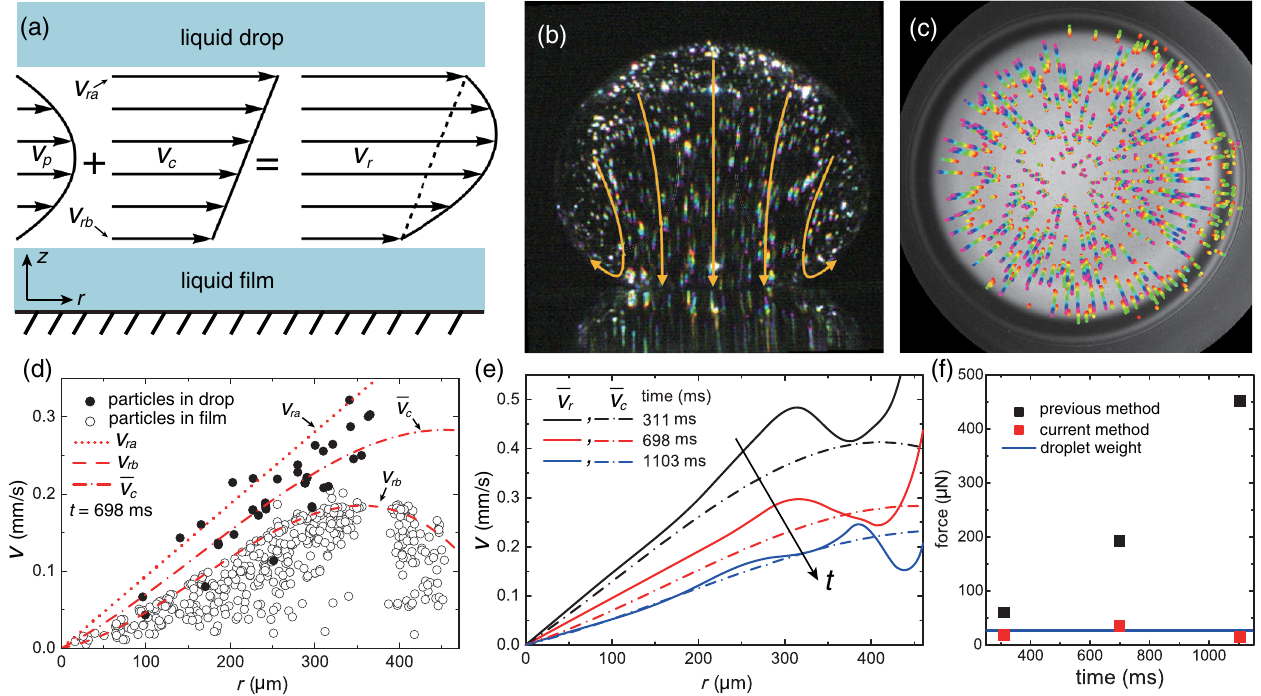
FIG. 3. Boundary velocities significantly influence air leakage. (a) Velocity profiles inside air gap. The total velocity v is composed r from pressure gradient plus a linear profile v caused by boundary velocity. v and v are upper and lower by two parts: a parabola v p c ra rb boundary velocities, respectively. (b) Side view image illustrating the flow inside droplet (also see Movie 4). The bright streaks are tracer particles ’ trajectories moving from the red end to the purple end. This flow provides the outward boundary velocity v from the droplet ra side. (c) Bottom view image illustrating the flow inside liquid film (also see Movie 5). Again, the bright streaks are tracer particles ’ from the liquid film side. trajectories moving from the red end to purple. This flow provides the outward boundary velocity v rb (d) Obtaining v , v , and ¯ v experimentally. At time t ¼ 698 ms, we obtain v and v from tracking particles in droplet (solid ra rb c ra rb symbols) and liquid film (open symbols), respectively. Because particles ’ velocities decrease as their locations are further away from (dotted line) and v (dashed curve). Their average boundary, we use the upper bound of their velocities as the boundary velocities v ra rb v v = 2 (dash-dotted curve). (e) ¯ v (solid curve) and ¯ v (dash-dotted curve) decrease with time, and ¯ v takes a major gives ¯ v c ¼ ð ra þ rb Þ r c c fraction in ¯ v . (f) Comparison of lubrication force F calculated from our method and a previous method (Appendix A 4). Our method r (red symbols) agrees with the droplet weight (blue line) while the previous method (black symbols) does